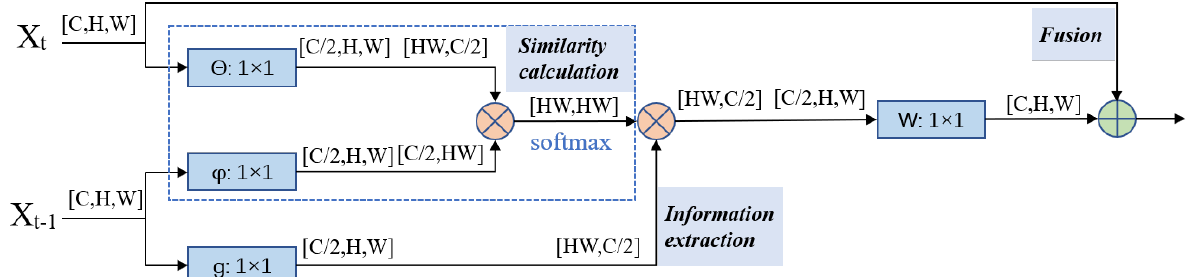
Figure 5. Non-local module. The blue symbols represent 1 × 1 convolutions, the orange symbols represent matrix multiplication, and the green symbols represent element-wise